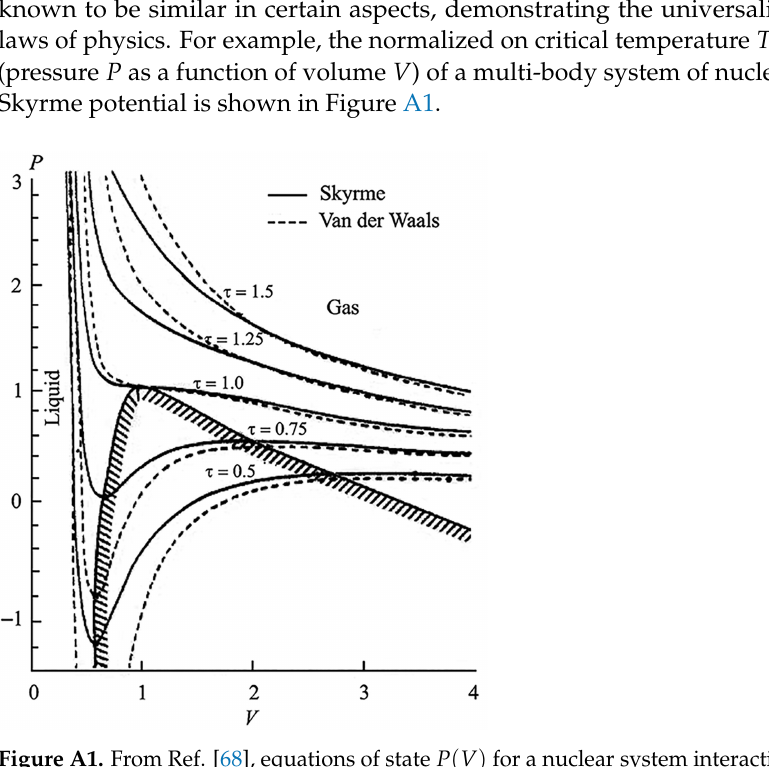
Figure A1. From Ref. [68], equations of state P ( V ) for a nuclear system interacting through a Skyrme potential and a Van der Waals compressible liquid–gas system (shown in relative units): qualitative similarity is